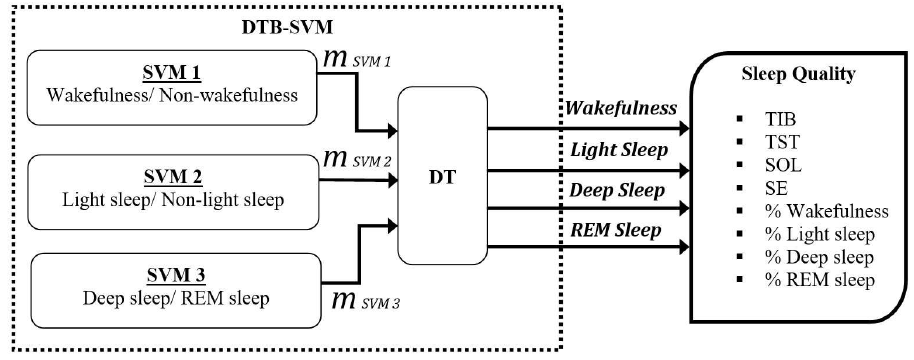
Figure 4. General scheme of Decision-Tree-Based Support Vector Machine